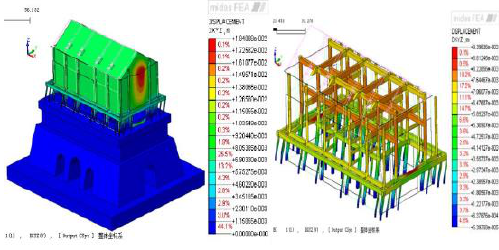
Figure 15. Structural deformation of